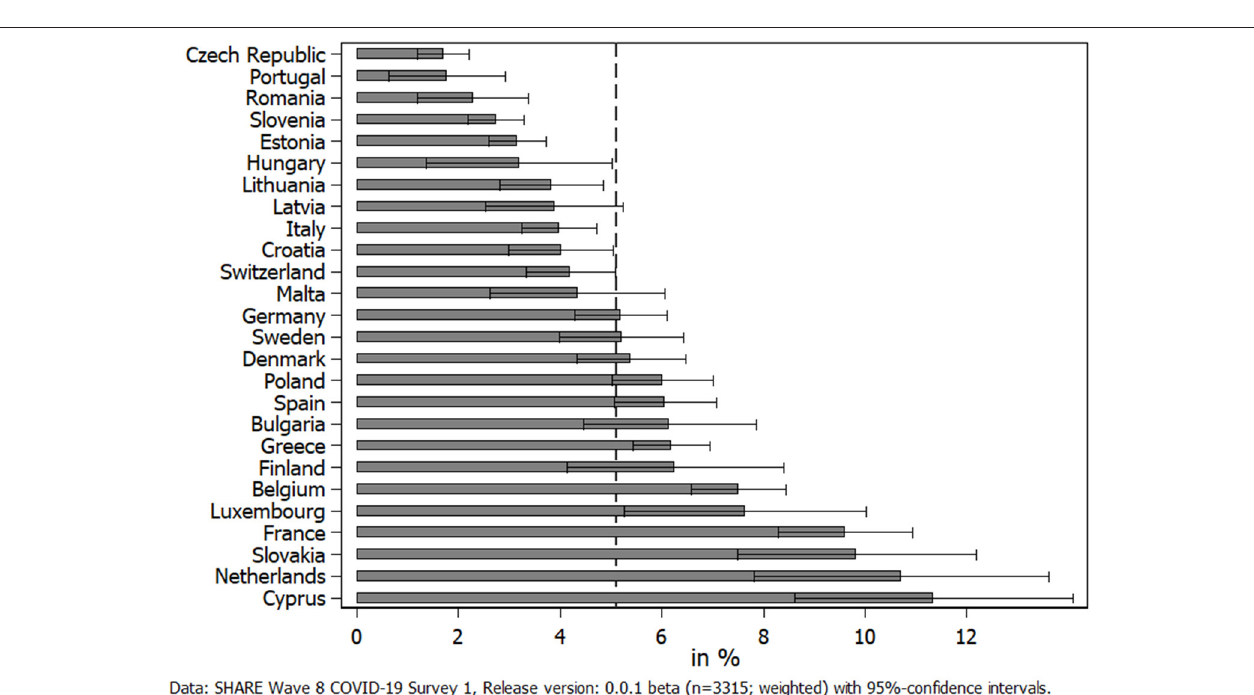
and Cyprus had much younger samples (between 65 and 66 years), but both exhibited a much higher share of